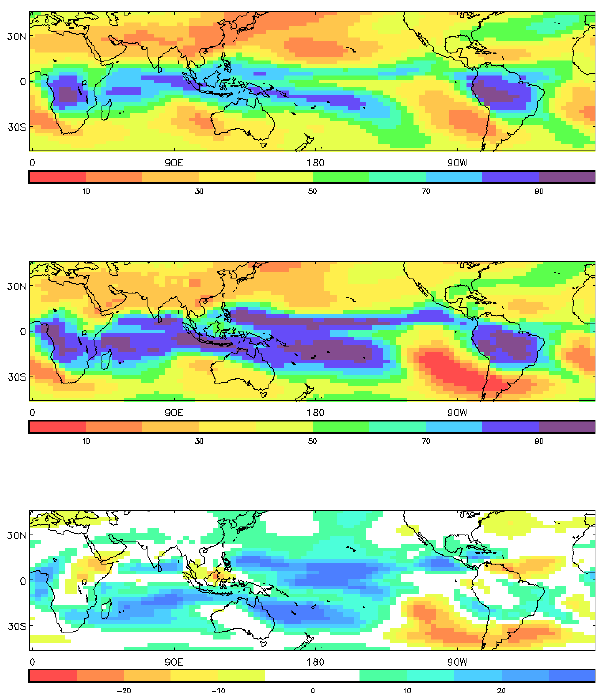
Fig. 4. As for Fig. 3 but for Relative Humidity averages in Decem- ber, January and February at 200hPa.